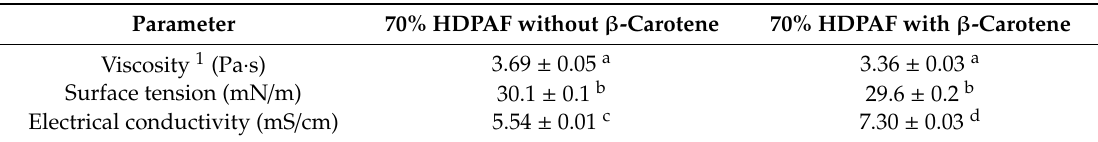
Table 1. Physicochemical characterization of the 70% high degree of polymerization agave fructans (HDPAF) polymer solution with and without β